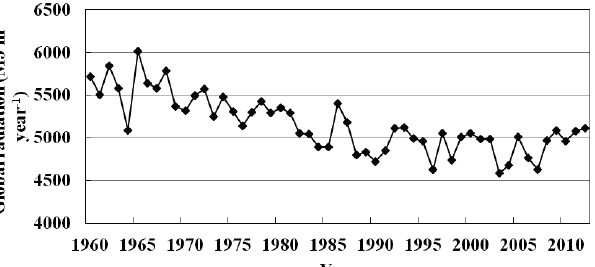
Fig. 2 Change of annual global radiation averaged from the six stations in Hai River basin 1960−2012.